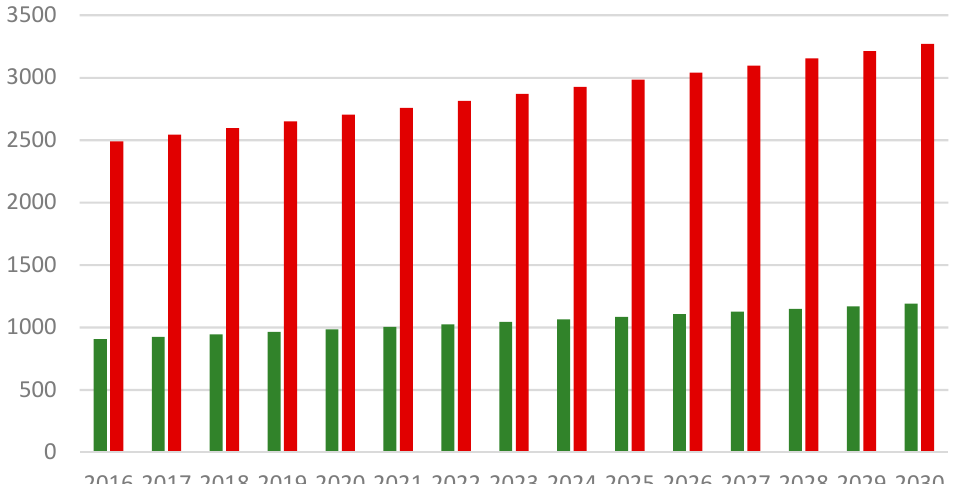
Figure 10. Firewood demand in rural households under the BAU scenario. (Thousands of Barrel of Oil Equivalent per year).